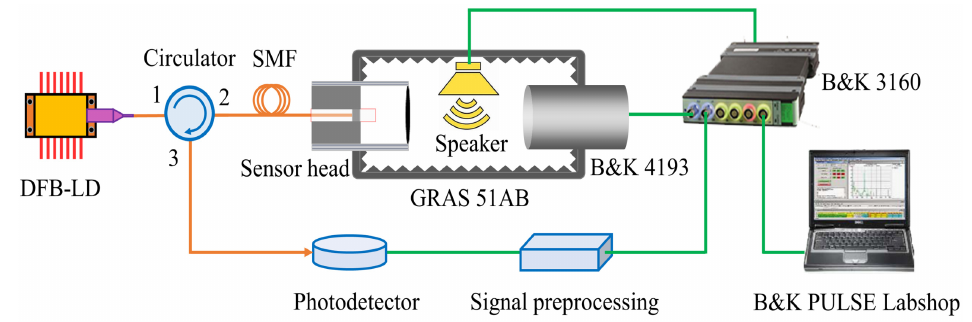
Figure 4. Schematic diagram of the acoustic test system used in this work.